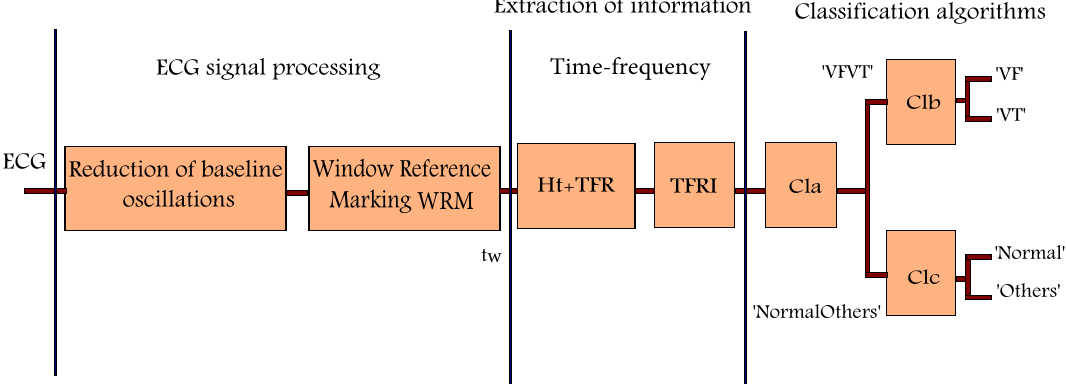
Figure 1. General diagram of the processing steps performed for the detection of Ventricular Fibrillation. After the reduction of the baseline oscillation and the calculation of the reference marks, the Hilbert transform (Ht) and the time-frequency representation ( TFR ) for a time window ( t w ) is obtained. Optionally, the possibility of obtaining the equivalent image from the TFR ( TFRI ) is used to serve as input to the combined classifier using three cascaded classifiers ( Cla , Clb , Clc ) where all of them are the same type ( Cla = Clb = Clc ) or combined Cla _ Clb _ Clc in case at least one classifier among them ( Cla , Clb , Clc ) is